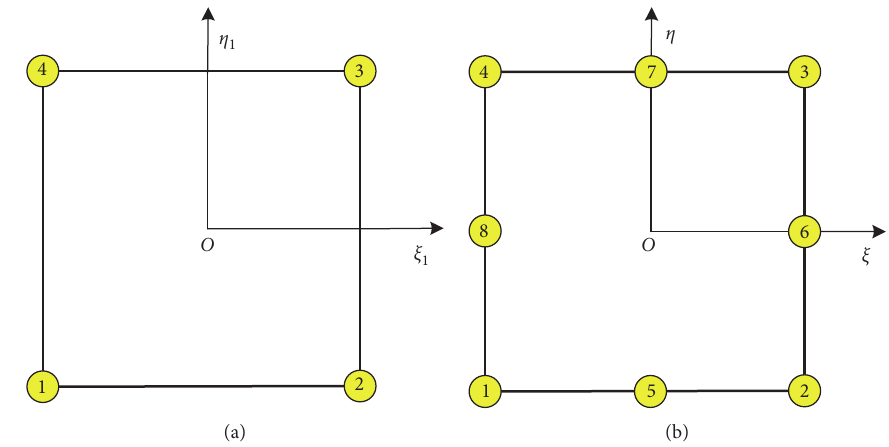
Figure 2: The isoparametric element. (a) Linear element with 4 nodes. (b) The quadrilateral element with 8